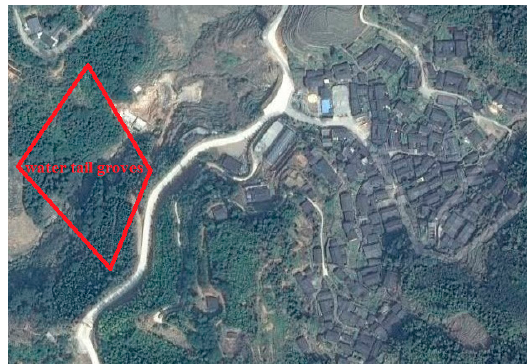
Figure 2. Water tail forests in Guifeng Village.